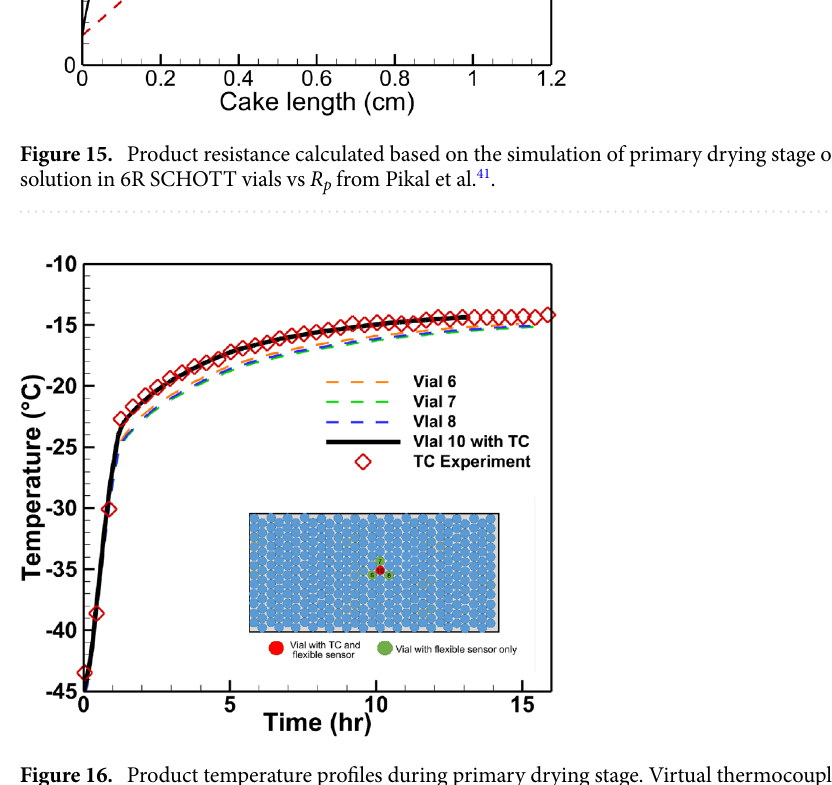
Figure 16. Product temperature profiles during primary drying stage. Virtual thermocouple readings for vials without thermocouple (Vial 6, 7, 8), vial with thermocouple (Vial 10 with TC) and experimental thermocouple readings (TC